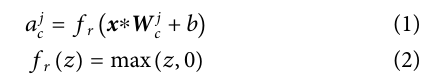
FIGURE 4 | Architecture of